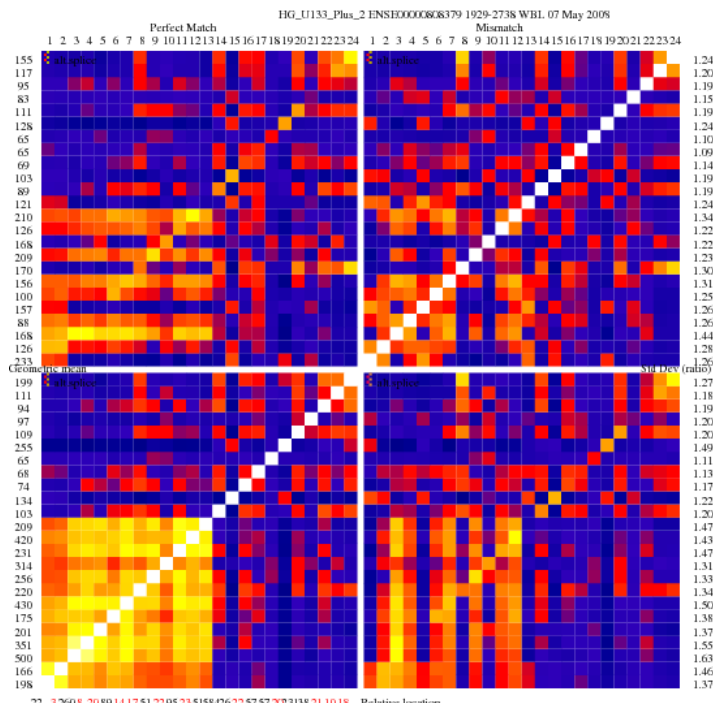
Figure 11: A correlation matrix for exon ENSE00000808379 with probes from HG-U133 Plus 2. Probes 1-13 lie before a polyA site and probes 14-24 are after. The matrix suggests that the Gene- Chips are detecting expression from transcripts which frequently use this site, as there is little correlated expression beyond the site. The numbers under the lower left quadrant (PMvsPM) de- tail the position of probes on the exon. The 1st base of probe 1 is at position 22 with respect to the start of the ENSEMBL exon, and the 1st base of probe 2 is at position 25 (22 +